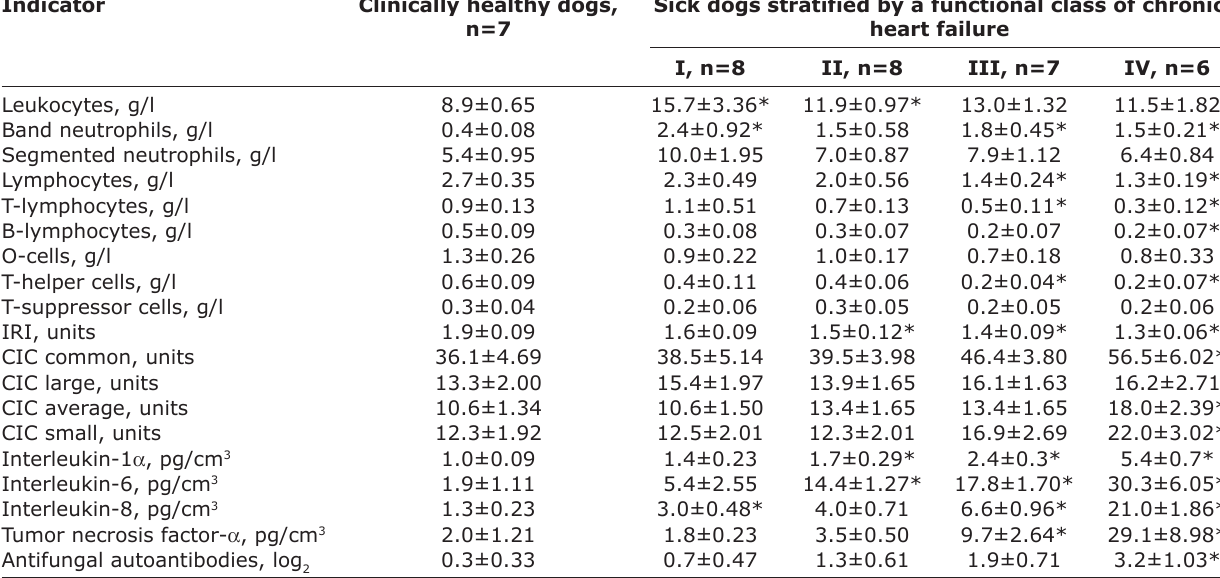
Table-1: Immunologic parameters of dogs with dilated cardiomyopathy according to their functional class of heart failure.